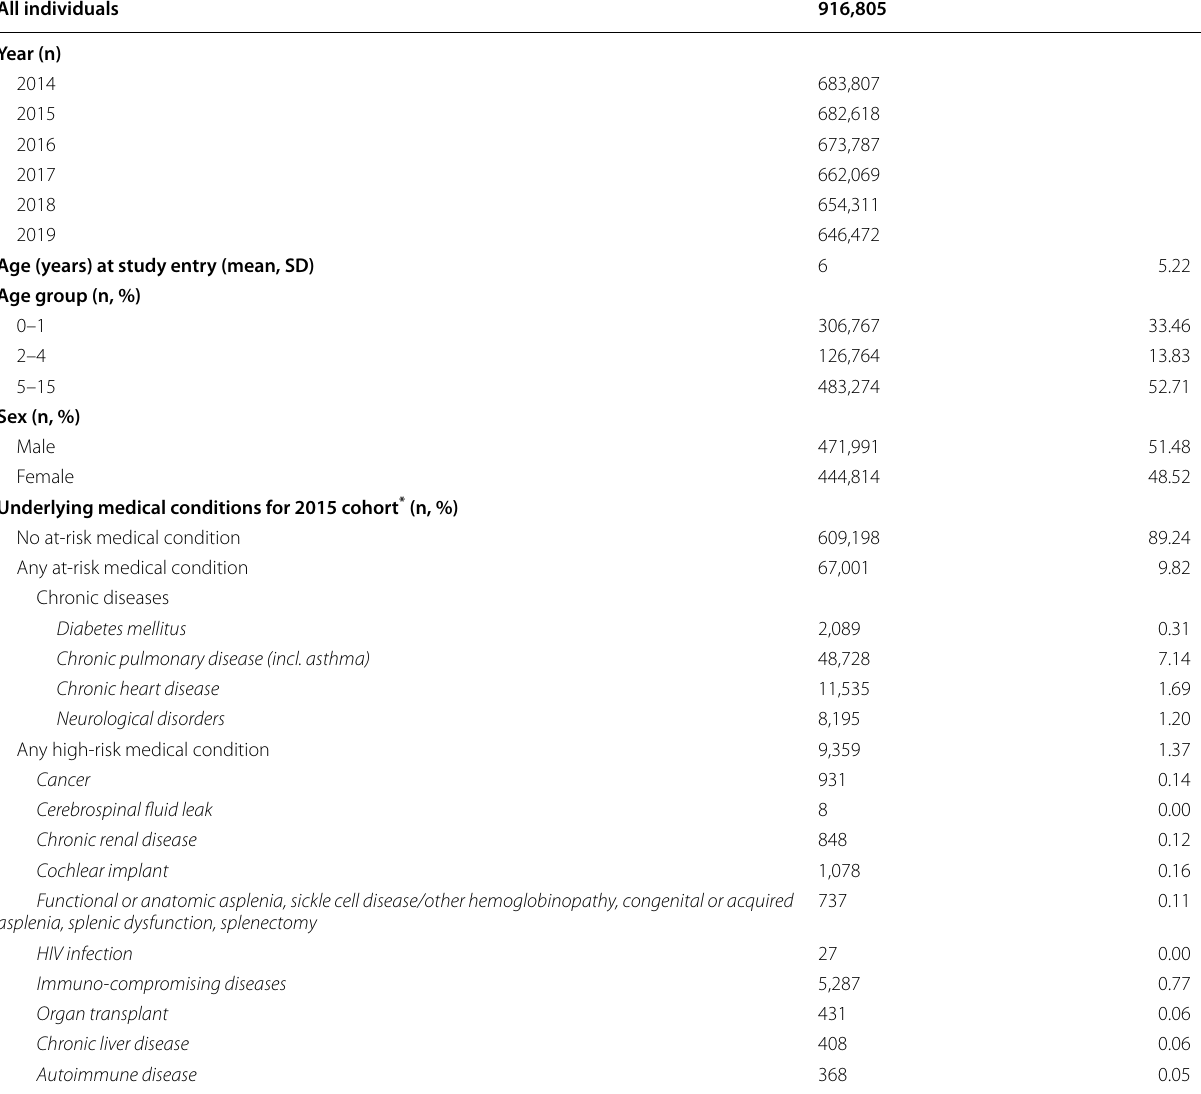
Table 1 Baseline characteristics of the study